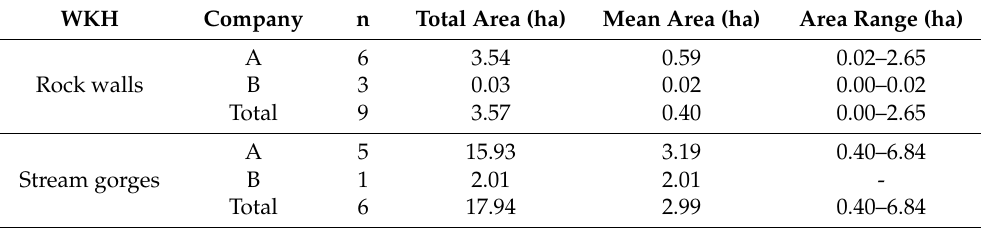
Table 1. Summary of field delineated rock walls and stream gorges by the two companies. WKH Company n Total Area